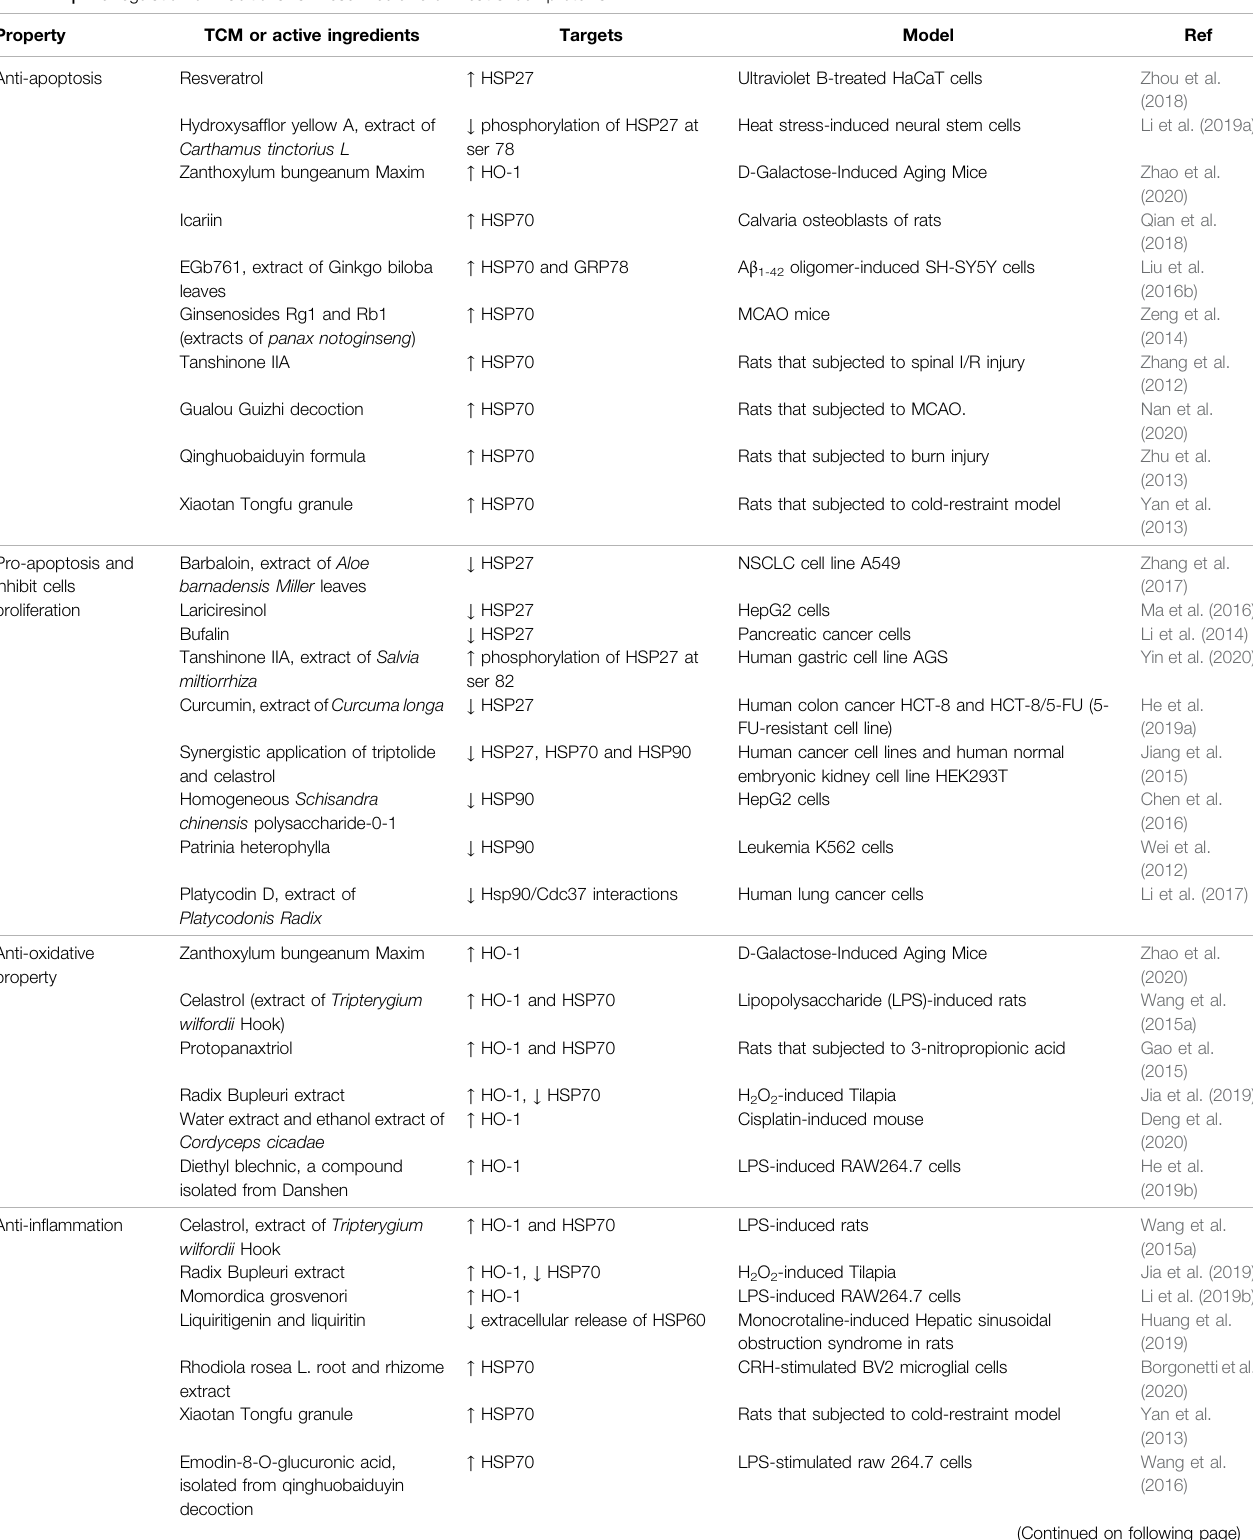
TABLE 2 | The regulation of Traditional Chinese Medicine on heat shock proteins.